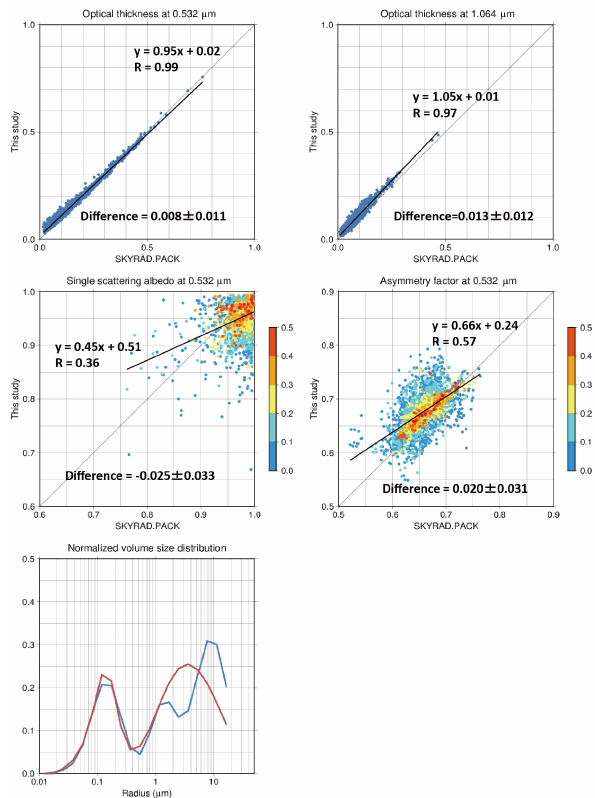
Figure 21. Comparisons of the columnar optical properties esti- mated by SKYLIDAR algorithm (this study) and SKYRAD.PACK during 2012 and 2013 in Tsukuba, Japan. The colors in the single- scattering albedo and asymmetry factor panels show the aerosol op- tical thickness at 532nm. In normalized volume size distribution panel, red indicates the SKYLIDAR result, and blue indicates the SKYRAD.PACK result.